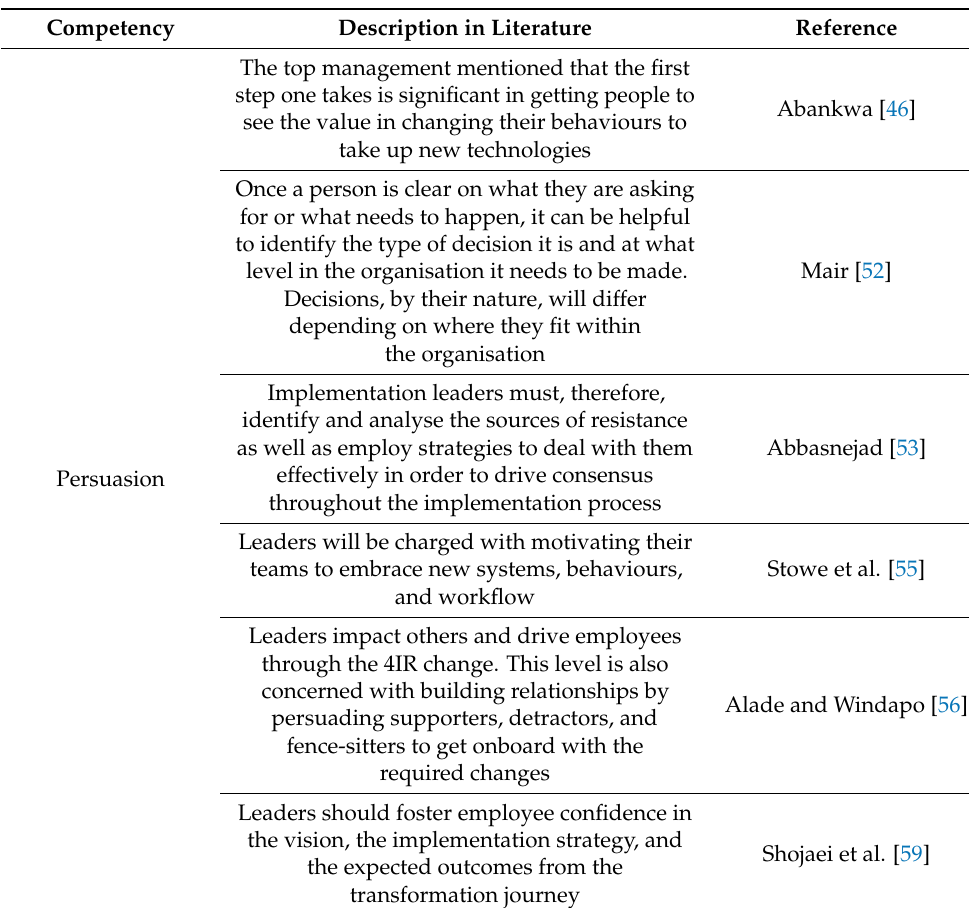
Table 2. Example of competency summary